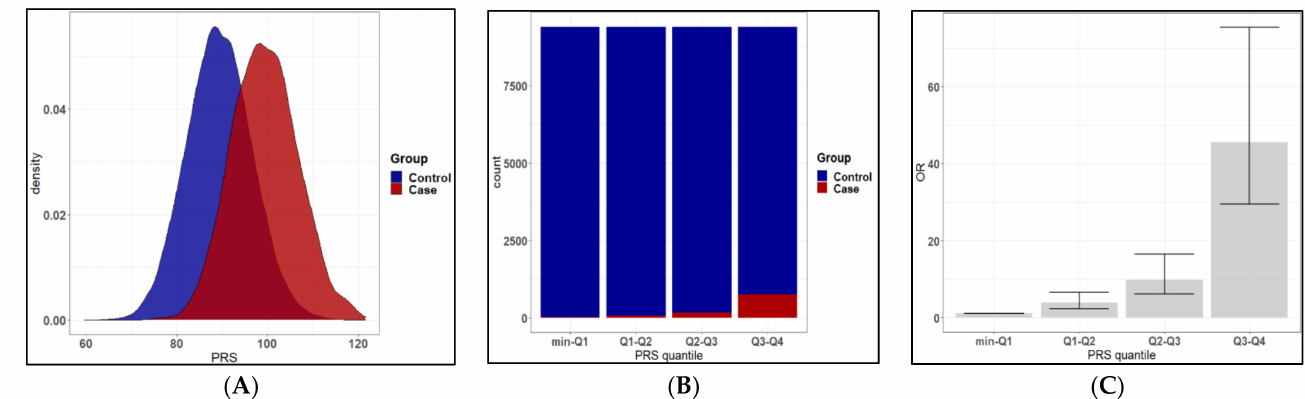
Figure 2. Comparison of glaucoma risks in TWB2.0 classified by PRS_TWB2.0 quantile. ( A ) Distribution of the polygenic risk score (PRS) in glaucoma cases and controls (the red and blue lines represent mean PRS in glaucoma cases and controls, respectively). ( B ) Distribution of cases and controls according to PRS quantiles. ( C ) Odds ratio (OR) for developing glaucoma according to PRS_TWB2.0